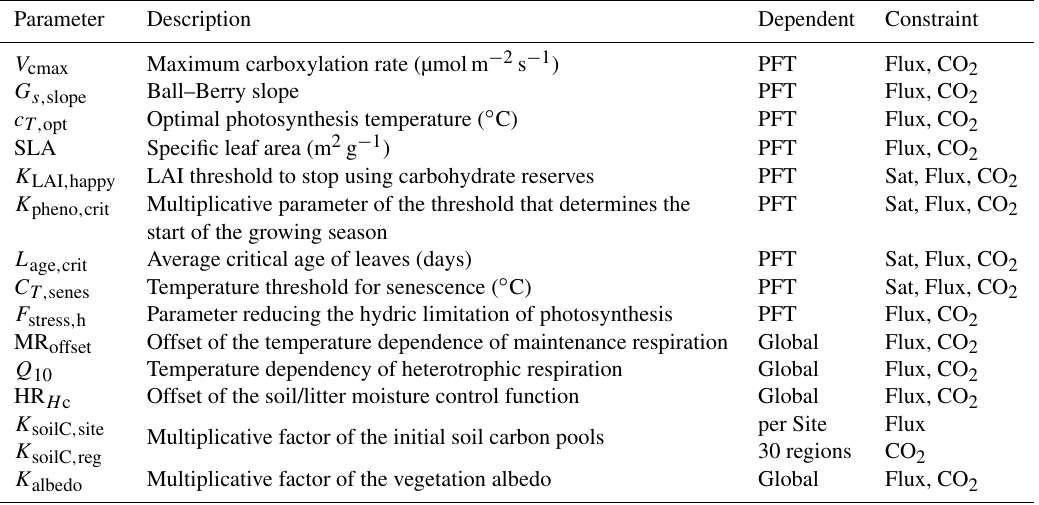
Table 1. Parameters description, generality (PFT dependent, global, specific to FLUXNET sites or for a set of regions) and data stream(s) that were used to constrain